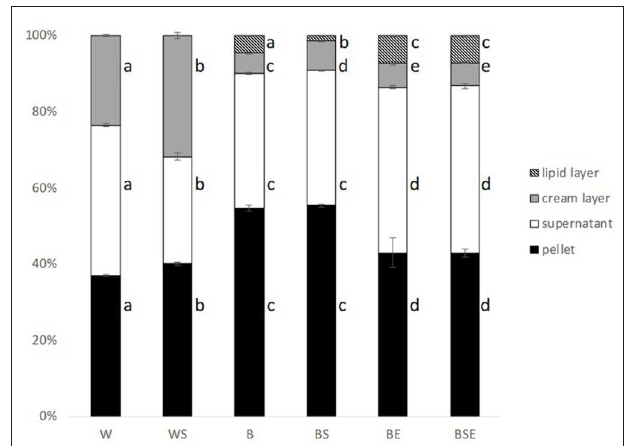
FIGURE 5 | Weight based fraction distribution of centrifuged samples after different treatments (fresh basis). W, washed; WS, washed and sonicated; B, blanched; BS, blanched and sonicated; BE, blanched and enzyme; BSE, blanched; sonicated and enzyme treated. ( n = 3; error bars represent standard deviation) Different letters indicate statistical difference ( p <